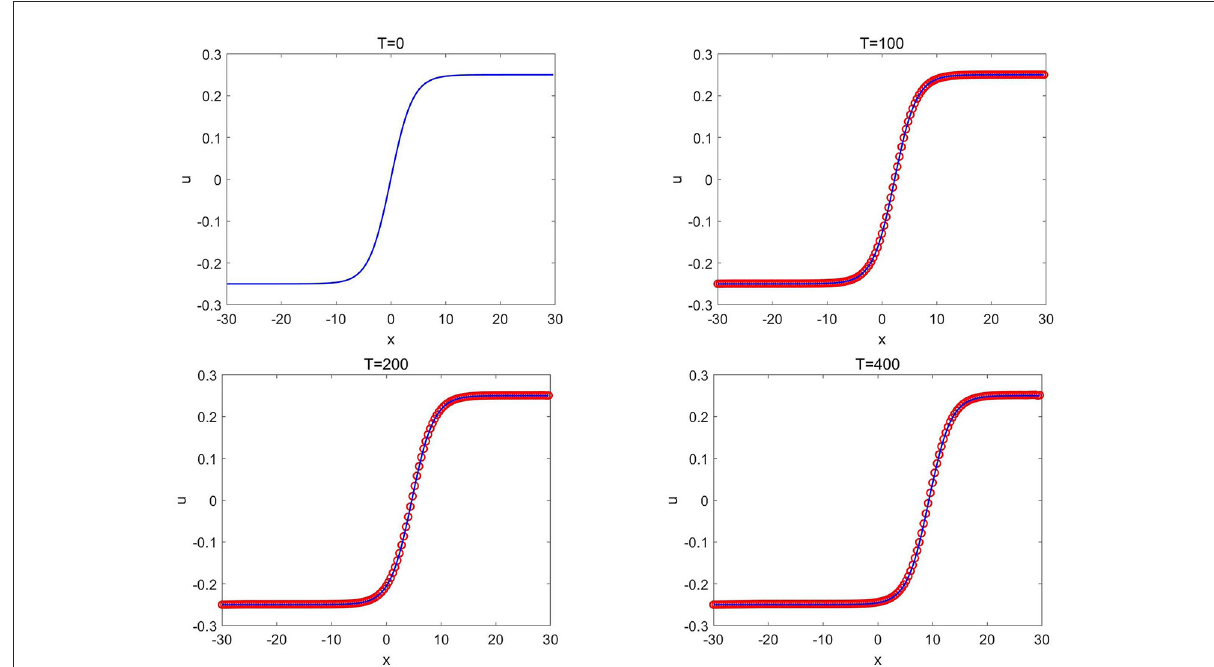
FIGURE12 Ito’s fifth order mKdV equation of Example 3.7: the CANN solution (red circles) and the exact solution (solid blue lines) at different time T with κ 0.25 and x 0 0. = =